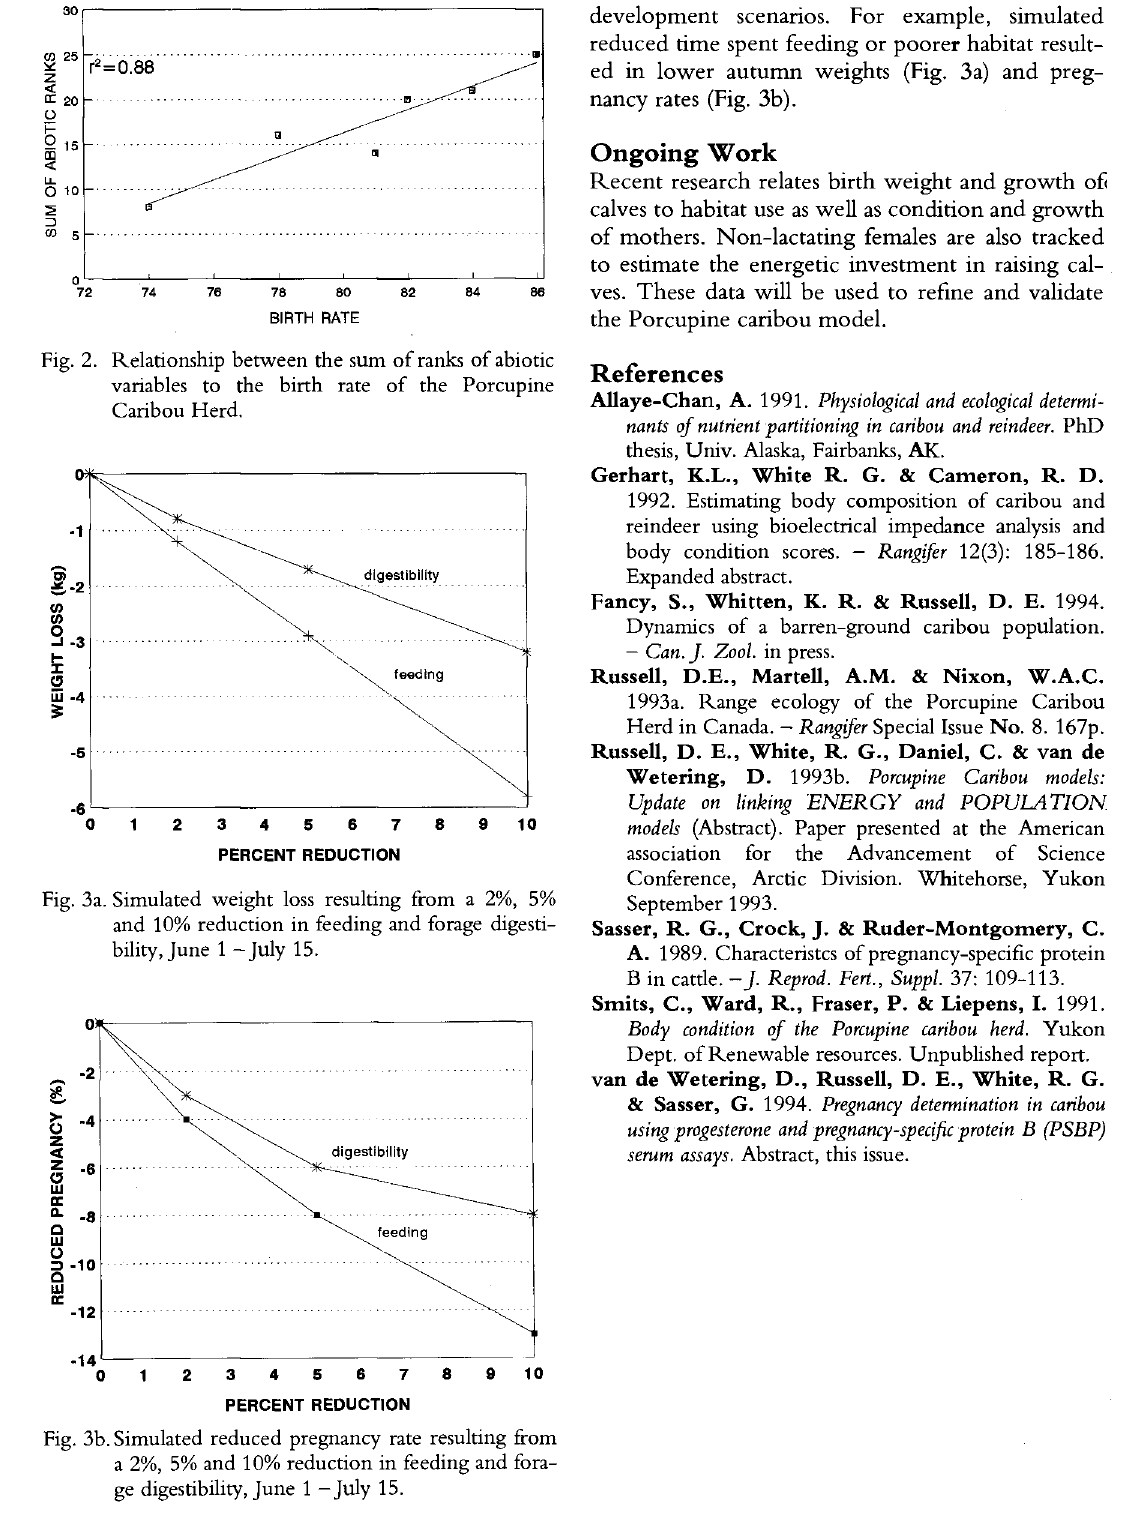
Fig. 3b. Simulated reduced pregnancy rate resulting from a 2%, 5% and 10% reduction in feeding and fora ge digestibility, June 1 - July